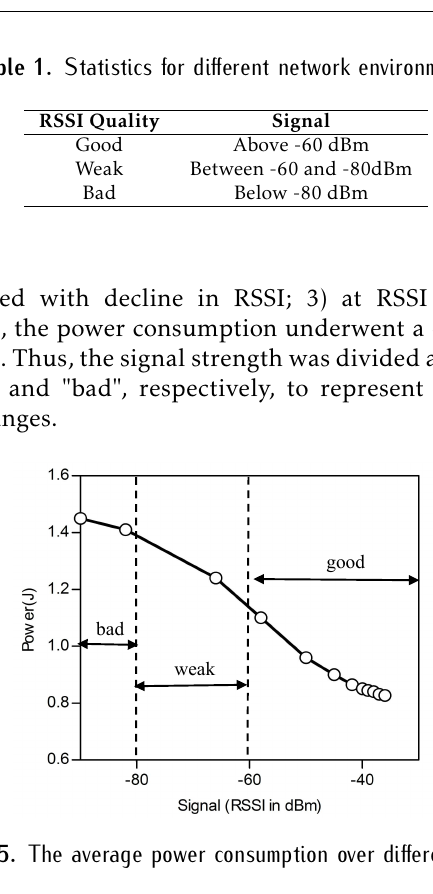
Fig. 3. (a) The jitter of Wi-Fi signal when the smartphone was near to the AP